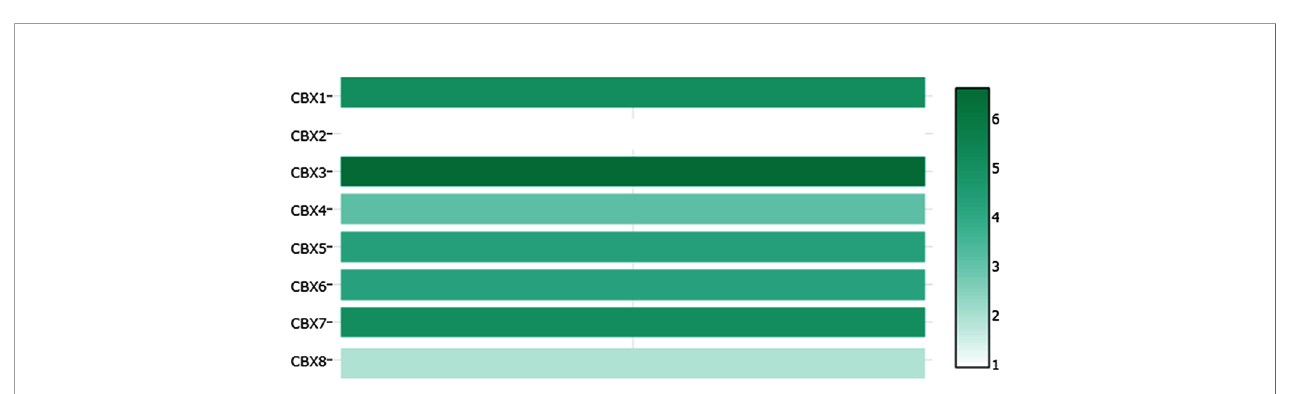
FIGURE 6 | The relative expression levels of CBXs in ccRCC